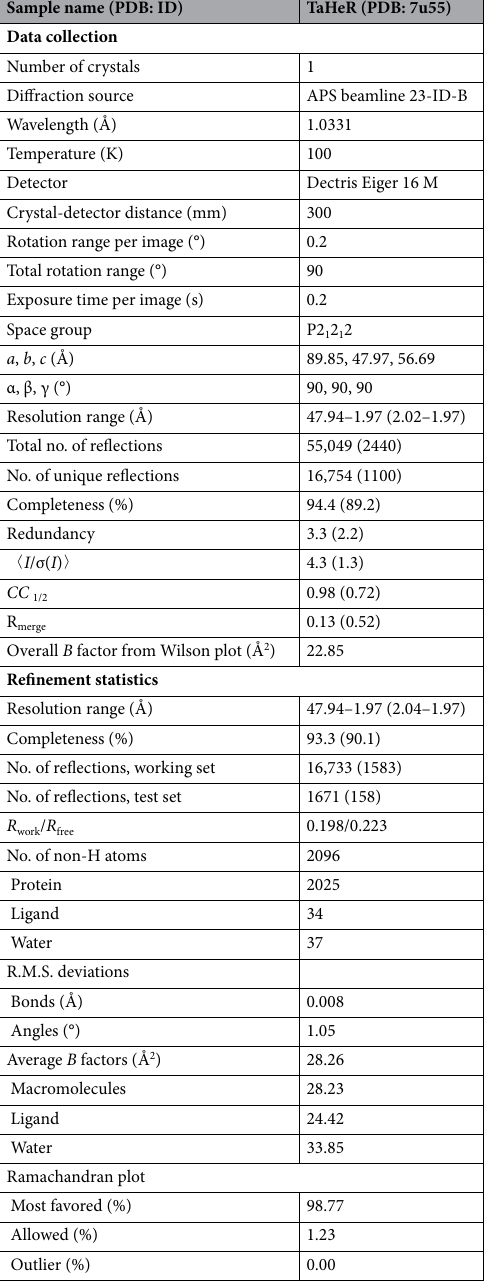
Table 1. TaHeR data collection and processing. CC 1/2 > 0.3 and 〈 I/σ(I) 〉 > 1.0 was used to determine cut-off. Values for the outer shell are given in